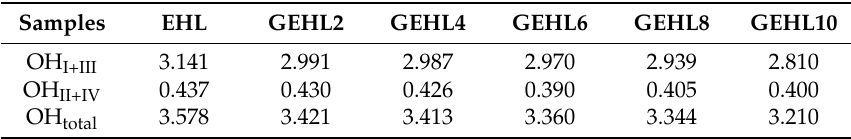
Table 3. The content of phenolic group in lignin samples.